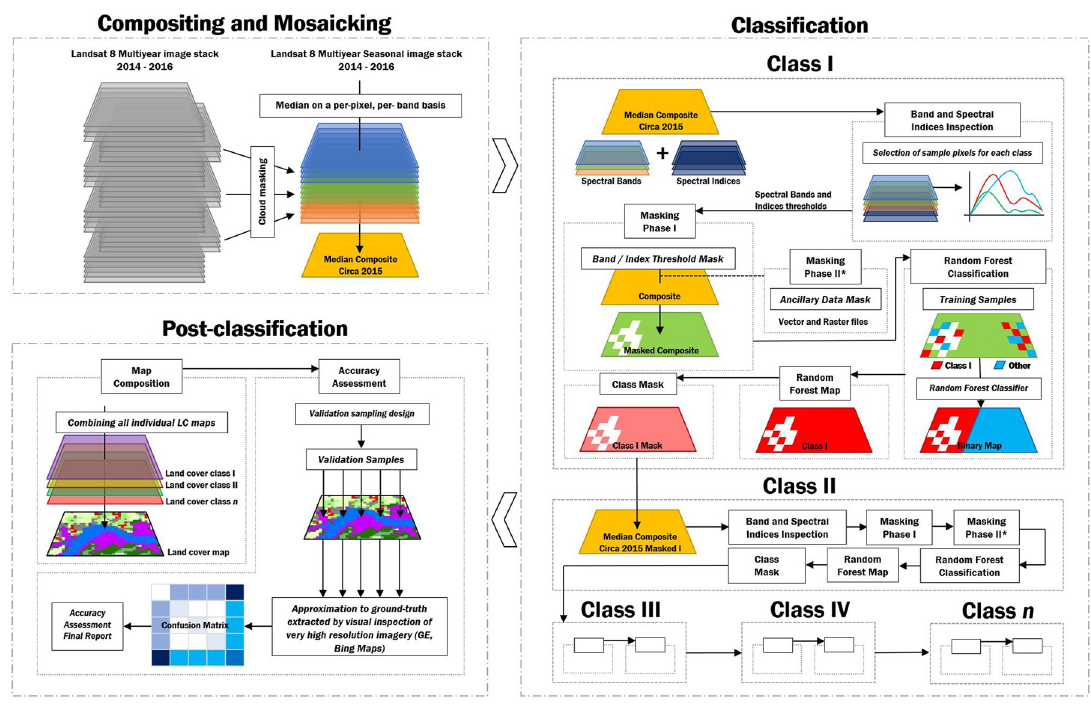
Fig 1. Schematic diagram of the methodology. Processes and respective sub-processes are represented by the different dashed boxes. Each dashed box is explained in the following sections.